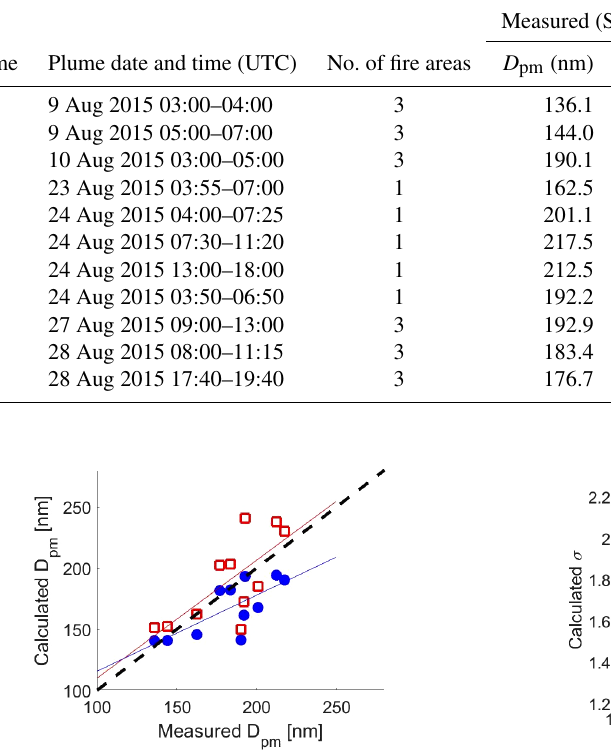
Table 2. The σ simplified fits using σ 0 = 2 . 4 have statis- tics of y = 0 . 50 + 1 . 00 and R 2 = 0 . 513 for σ( d M/ d x ) and